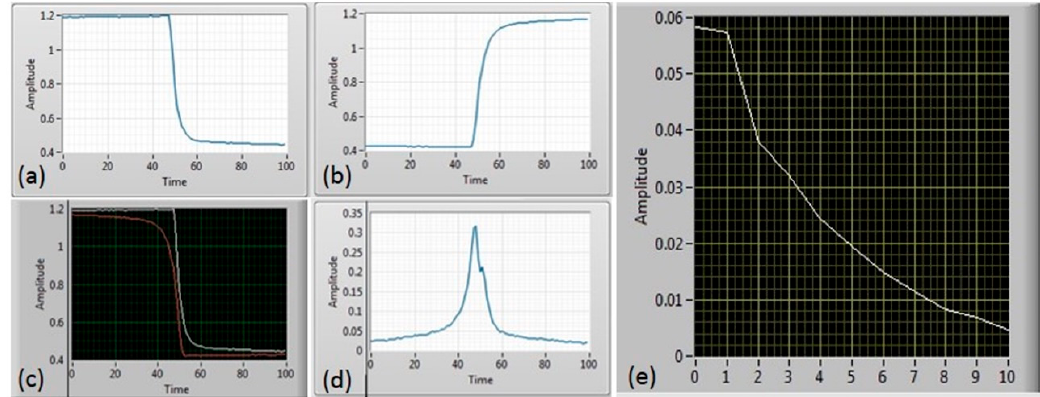
Figure 5. Thermal modulation steps visualized in LabVIEW. One sensor pulse is used as an example, the falling ( a ) and rising ( b ) part flipped ( c ), and subtracted ( d ). Results are then processed through FFT to get amplitude readings ( e ).